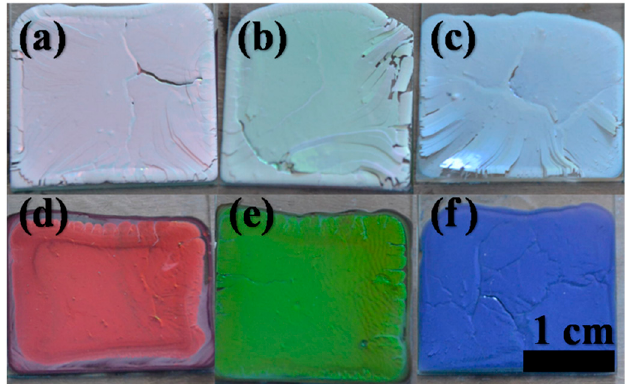
Figure 2. Optical photographs of the prepared structural color films with and without MWCNTs indoors under natural light without an external light source. ( a ), ( b ) and ( c ): red, green and blue films without MWCNTSs; ( d ), ( e ) and ( f ): corresponding films doped with MWCNTs; Hydrodynamic particle sizes were 317, 261, and 235 nm, respectively.